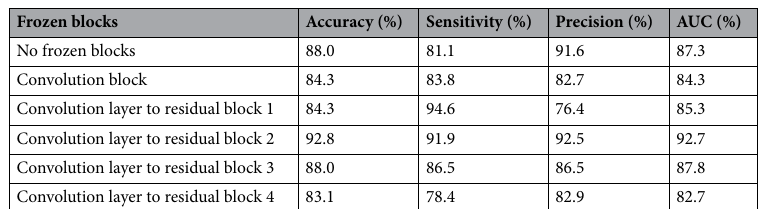
Table 4. Classification performance of the pre-trained D-classifier with different frozen blocks.